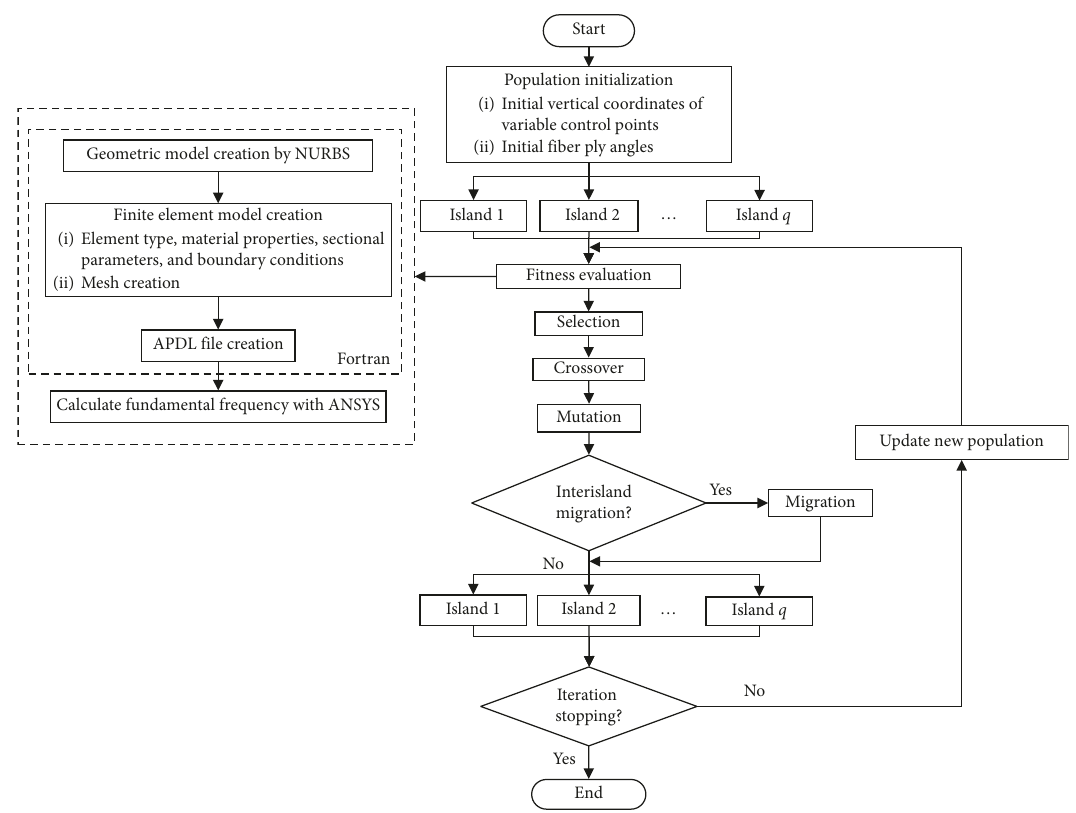
Figure 3: Flow chart of MIGA optimization process. Table 1: Material parameters of CFRP material